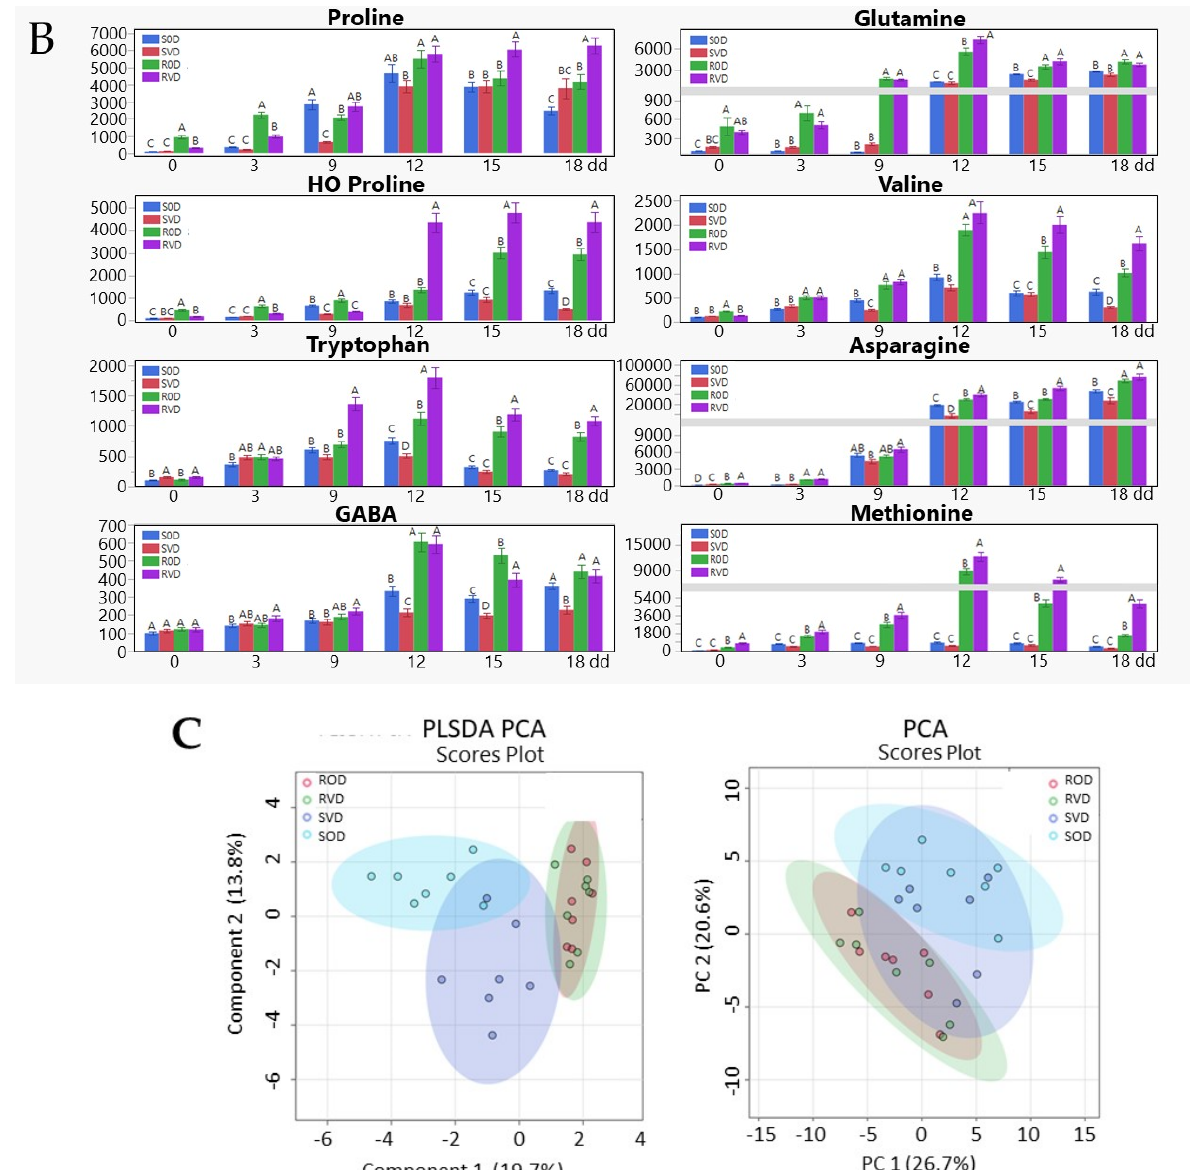
Figure 1. Stabilization of osmoprotectants patterns (sugars, amino acids) in R-GF967 vs. S-967 tomatoes under drought stress. Leaf samples were collected at 0, 3, 6, 9, 12, 15, and 18 dd after the beginning of water withholding from the four groups of experimental tomatoes R0D, RVD, S0D, and SVD. ( A ) Osmo-protective sugar patterns were shown for sucrose, glucose and fructose. The concentration of each sugar in S0D leaf the first day of sampling (0 dd) was considered as 100; the concentration of soluble sugar was calculated relative to this value. Bars represent the standard errors of the relative sugars’ levels from three independent biological repeats. Different lowercase letters (a–d) above the bars denote significant differences ( p < 0.05). ( B ) Osmo-protective amino acids patterns were shown for proline, HO-proline, valine, tryptophan, γ -aminobutyric acid, asparagine, glutamine, and methionine. The concentration of each amino acid in S0D leaf the first day of sampling (0 dd) was considered as 100; the concentration of each selected amino acid was calculated relative to this value. Bars represent the standard errors of the relative amino acids’ levels from three independent biological repeats. Different capital letters (A–D) above the bars denote significant differences ( p < 0.05). ( C ) Partial least-squares discriminant analysis (PLSDA) and principle component analysis (PCA) analyses. All the metabolome data for a given genotype at a given time are represented by a colored circle. Red: R0D; green: RVD; light blue: S0D; dark blue: SVD. Contrary to PLSDA, which considers the data supplied for each group, allowing to see the differences in each group, PCA is used for clustering when knowledge is not required. The two graphs show that R0V and RVD cluster together and are different from S0V and